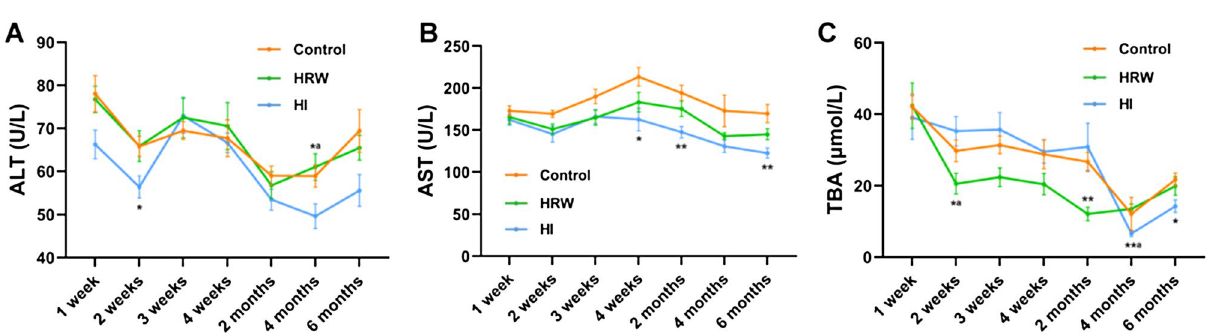
Figure 5. Effects of hydrogen treatment on liver function indexes. The levels of serum ALT (A) , AST (B) and TBA (C) were monitored throughout the experimental period. Values shown are mean ± SEM (n = 10). For comparison of HRW or HI group and Control group, * p < 0.05, ** p < 0.01. For comparsion of HRW and HI group, * a p < 0.05, ** a p < 0.01. Figure was made with GraphPad Prism 8.0.2, https ://www.graph pad.com/suppo rt/ faq/prism -802-relea se-notes